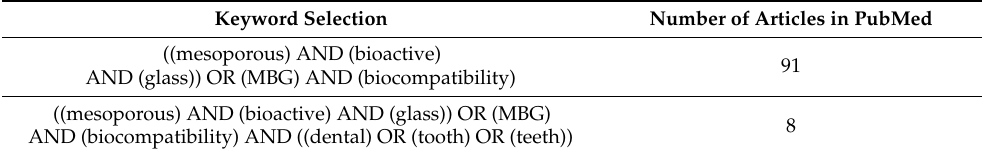
Table 1. Research equations explored.